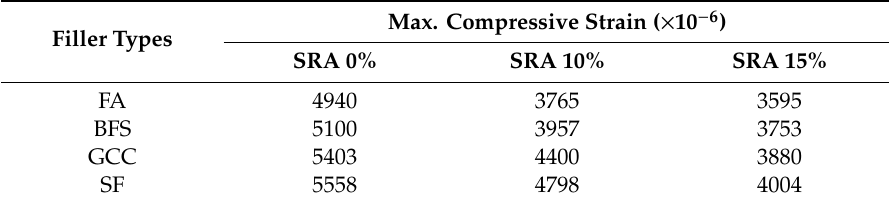
Table 10. Max. Compressive strains by SRA content and filler types.